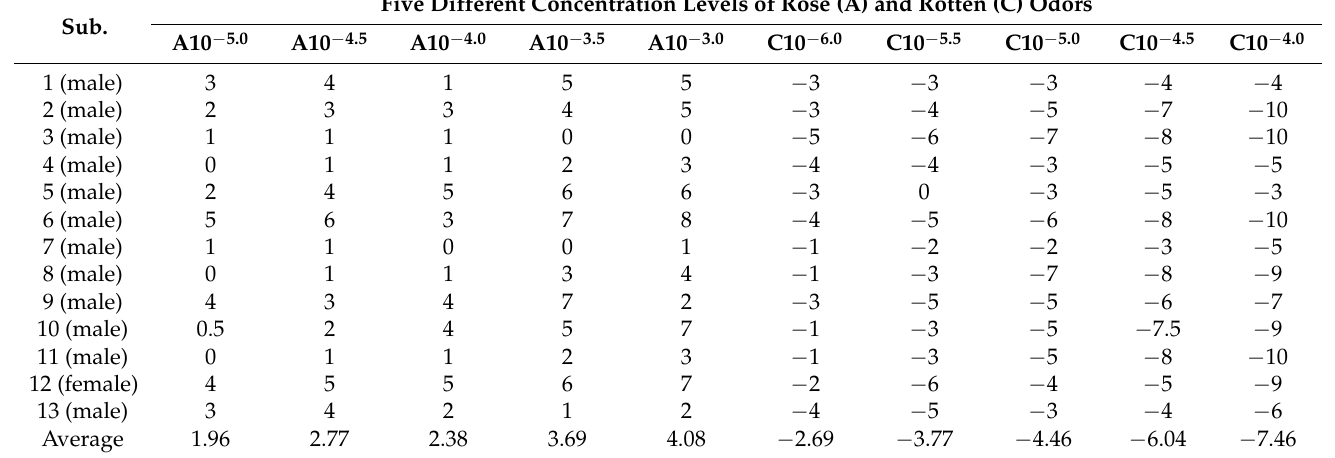
Table 1. The subjective evaluation scores of each participant. Five Different Concentration Levels of Rose (A) and Rotten (C) Sub.